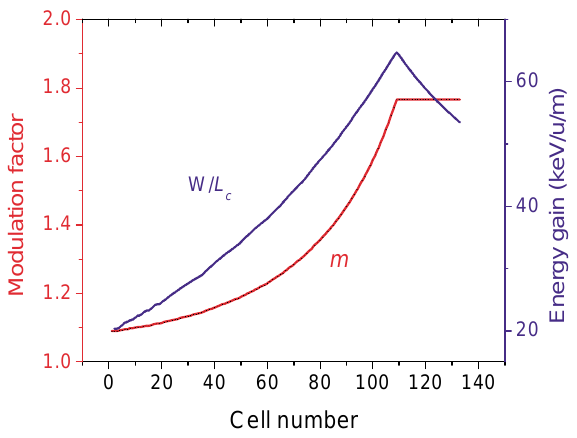
FIG. 3. (Color) Modulation factor m and energy gain W (cid:2) L c along the RFQ.